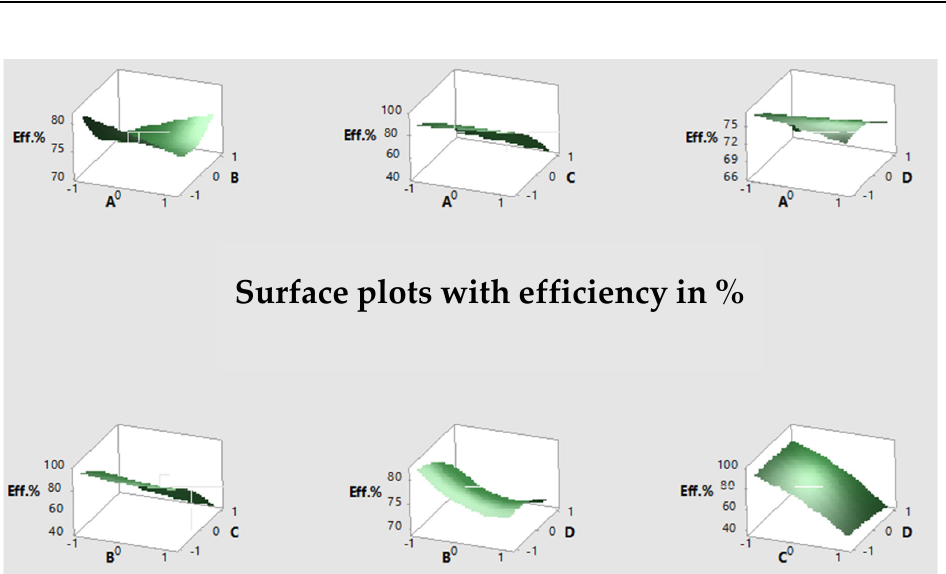
Figure 4. The 3D response surface plot for the interaction effect of two variables when crossed from the lower level ( − 1) to the upper level (+1) while keeping the other two factors at the middle level (0).